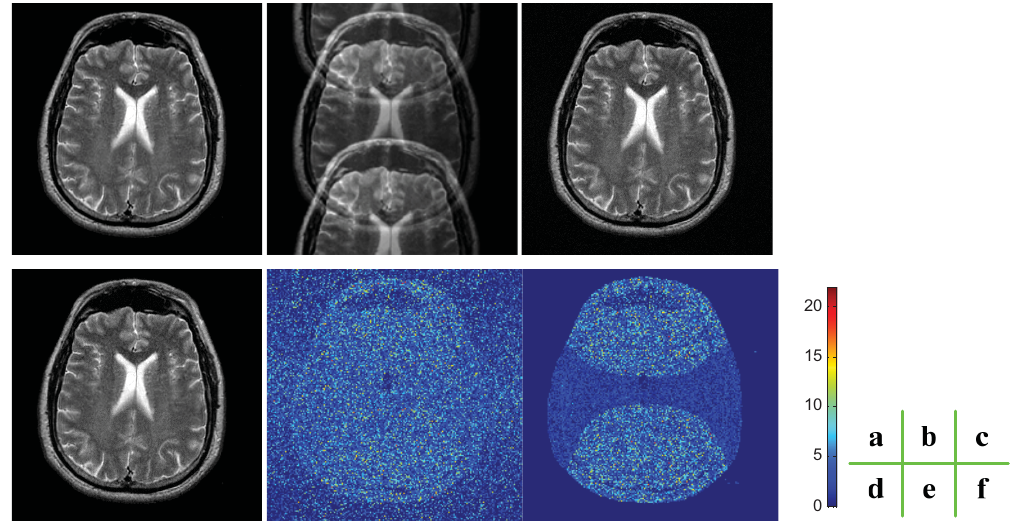
Figure 6. Comparison of the quality of the reconstructions: ( a ) Original, fully sampled -weighted brain MR image; ( b ) The aliased image; ( c ) Reconstructed image by ROS-based T 2 correction; ( d ) Reconstructed image by ROS-based reconstruction; ( e ) Difference between (c) and (a); ( f ) Difference between (d) and